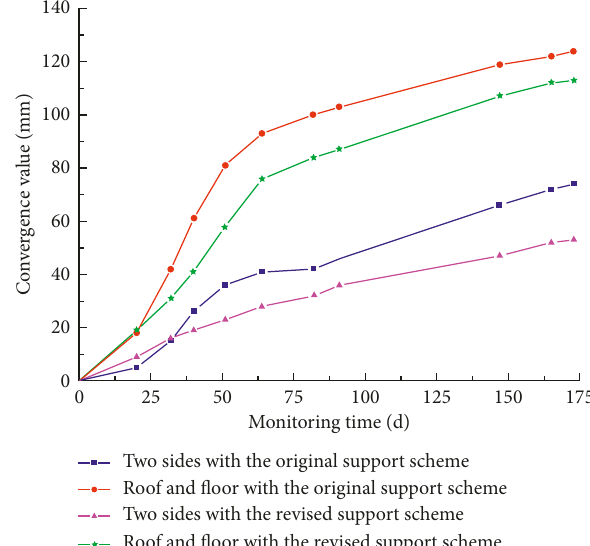
Figure 15: Comparison curve of deformation